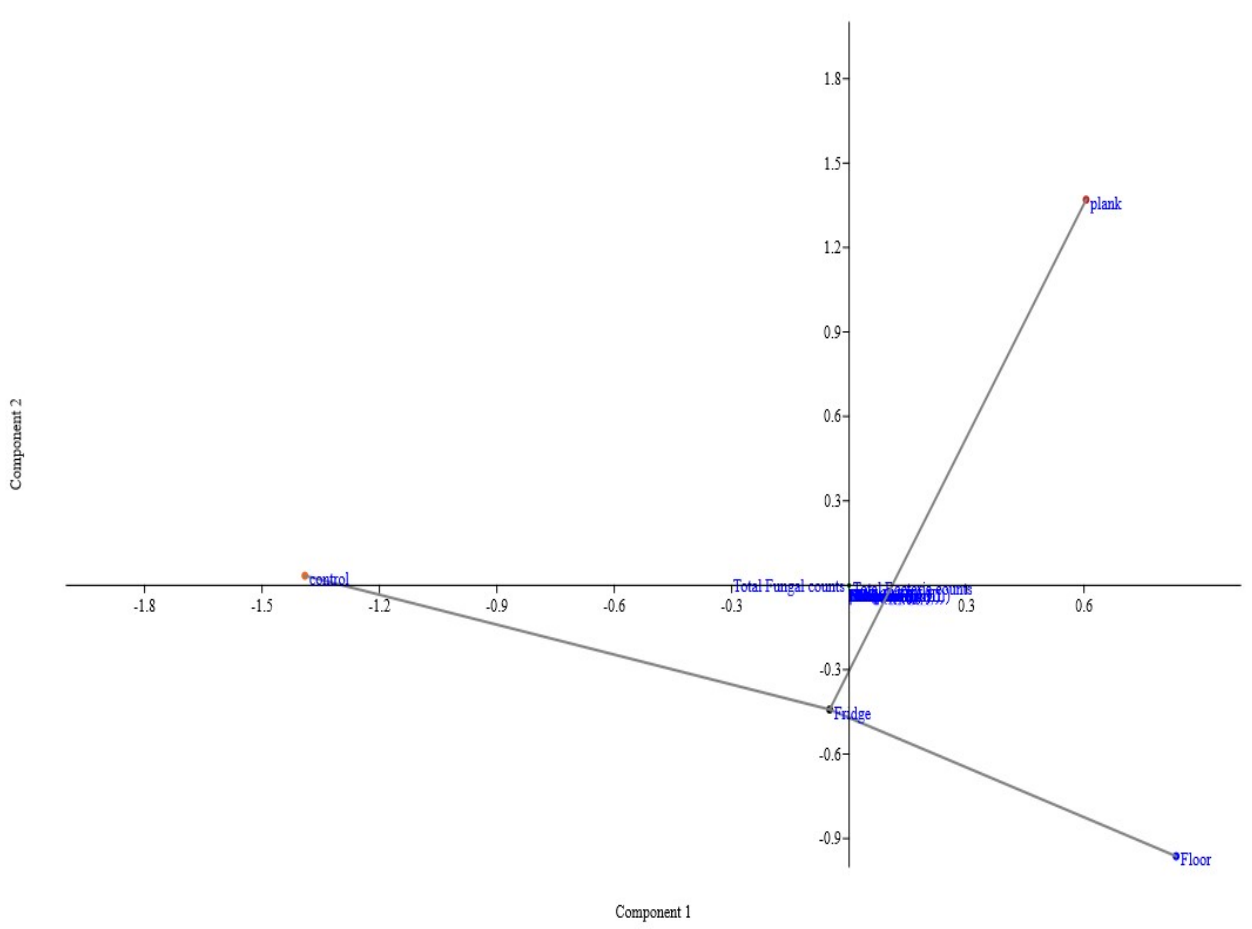
Figure 3. PCA showing the relationship between different storage conditions, physicochemical and microbial quality of the selected brands of sachet water.